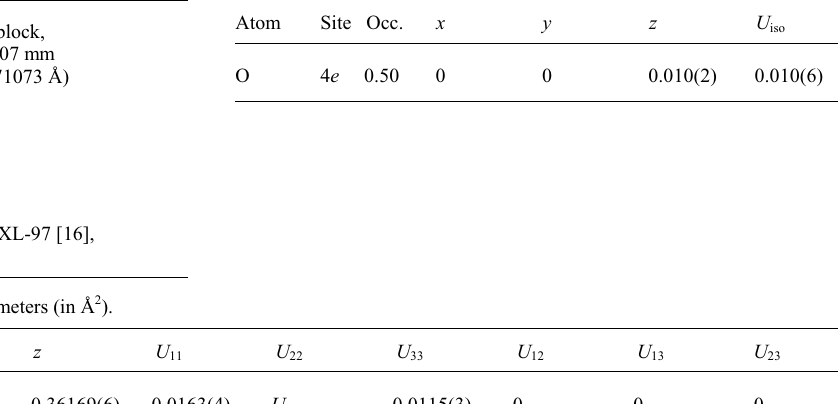
Table 1. Data collection and